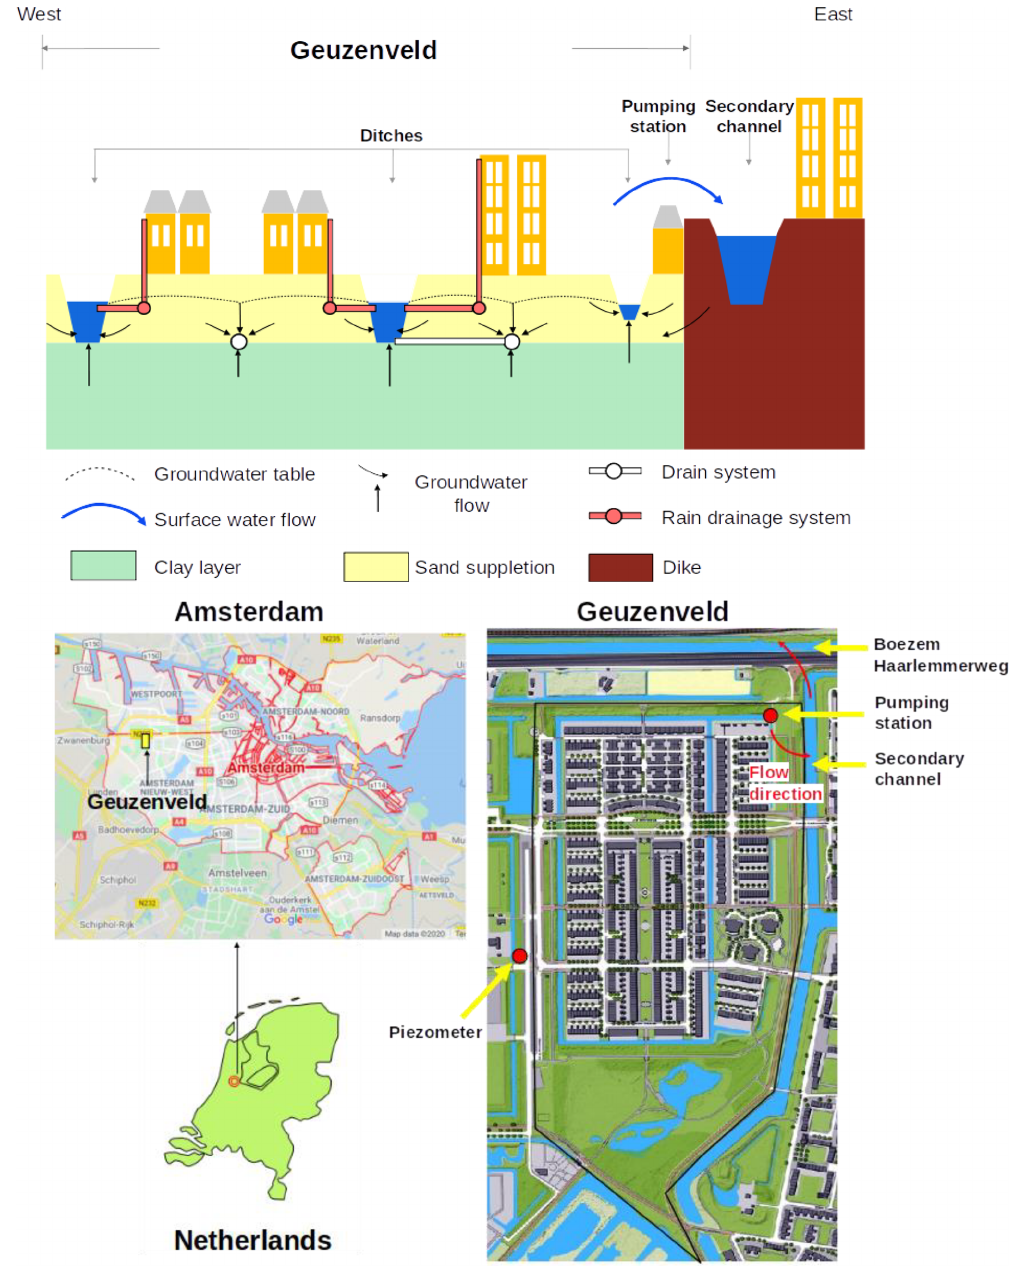
Figure 1. Location of polder Geuzenveld (source: © Google Maps) and its landscape cross section as well as rain water and groundwater drainage